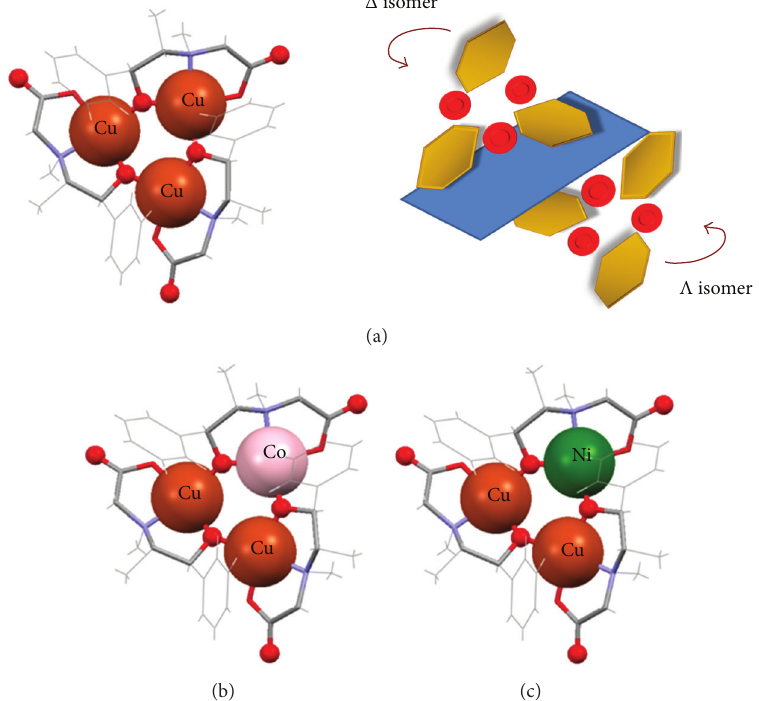
Figure 4: (a) Structure of the homotrinuclear [Cu 3 ( S,S (+)cpse) 3 (H 2 O) 3 ] ⋅ 8H 2 O compound, Δ isomer. Proposed structures for (b)